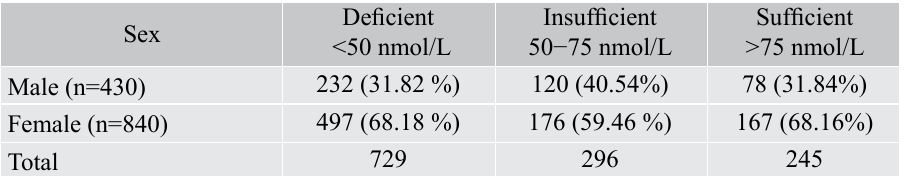
Table V: Distribution of vitamin D status in subjects of 41−60 years